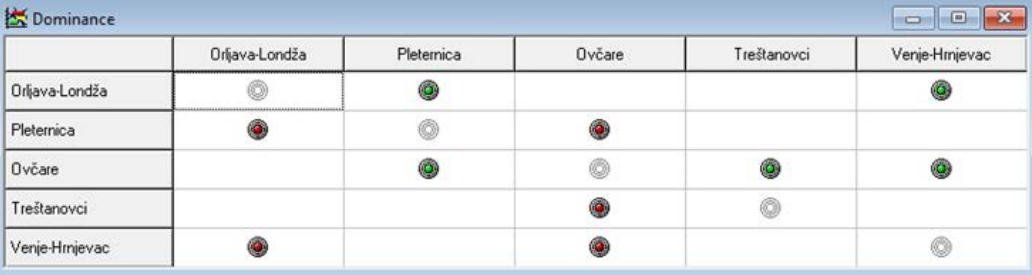
Figure 9. Range of possible values of alternatives for Scenario 1. Water 2019 , 11 , x FOR PEER REVIEW Figure 10. Dominance matrix of mutual relationships among alternatives for Scenario 1.